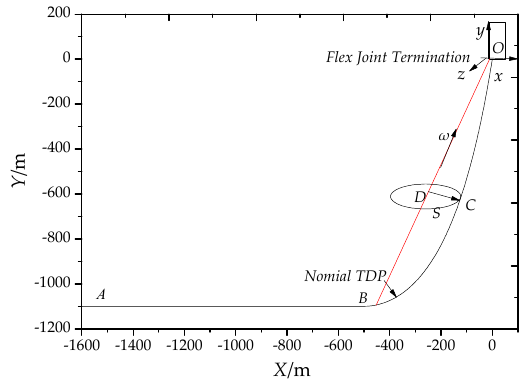
Figure 3. Rigid body swing system.